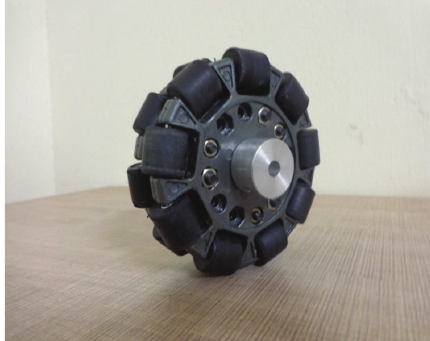
Table 2: Specifications of DC motor.